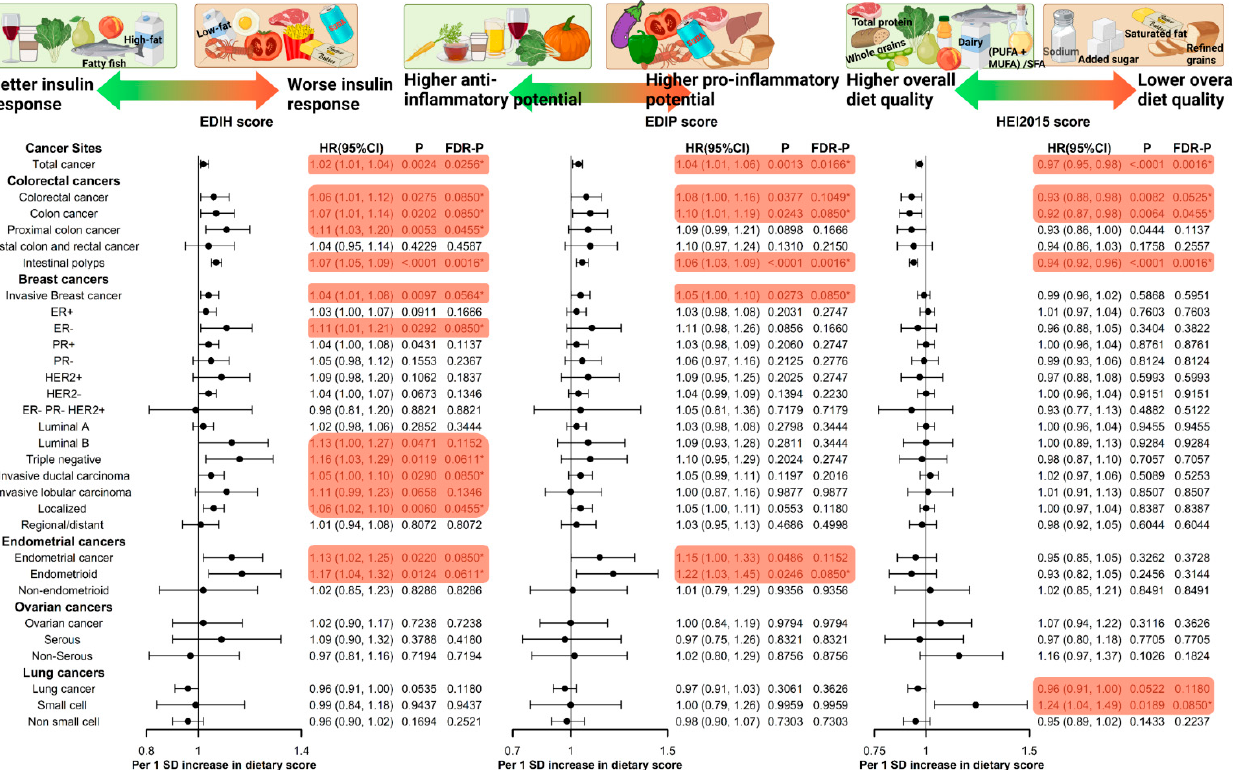
Figure 2. Associations between a 1 standard deviation increment in hyperinsulinemic, pro- inflammatory dietary patterns or higher overall dietary quality, and risk of incident total cancer, site-specific cancers, and pathological subtypes. Values are hazard ratios (HR) and 95% confidence in- tervals (95% CI) for cancer risk per 1 standard deviation increment in dietary score. Values in colored background/asterisk represent elevated risk (EDIH/EDIP), reduced risk (HEI-2015), or significant FDR-adjusted p -value at <0.15. HRs were derived from multivariable-adjusted Cox proportional hazards regression models adjusted for the following baseline covariates: age at enrollment, physical activity, race and ethnicity, educational level, family history of cancer, number of hormones used, co- morbidity score, baseline cardiovascular disease status, baseline lung disease, number of supplements used, non-steroidal anti-inflammatory drug use, hormone therapy study arm, baseline hormone therapy ever, oral contraceptive duration, pack years of smoking, coffee/tea, and total alcohol intake. Colorectal cancer and subtype analyses were additionally adjusted for colorectal cancer screening. Invasive breast cancer and subtype analyses were additionally adjusted for months of breast-feeding, age at menopause, mammogram ever, parity, bilateral oophorectomy, passive smoking, Gail 5-year risk score. Endometrial cancer and ovarian cancer analyses were additionally adjusted for age at first birth, age at menarche, age at menopause, months of breast-feeding, and